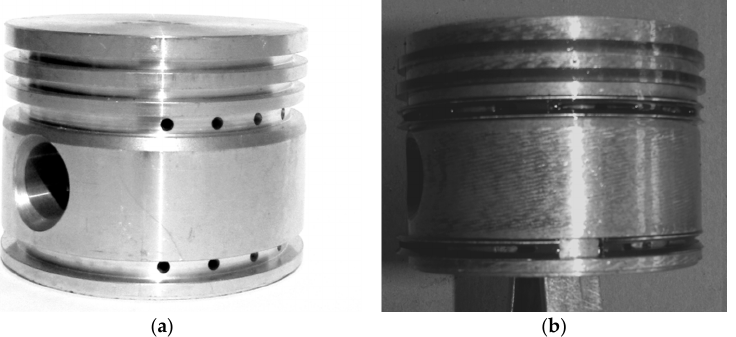
Figure 17. AlSi7Mg2Sr0.03/SiC p 10 vol % composite piston of air compressor: ( a ) after machining; ( b ) after scuffing test.